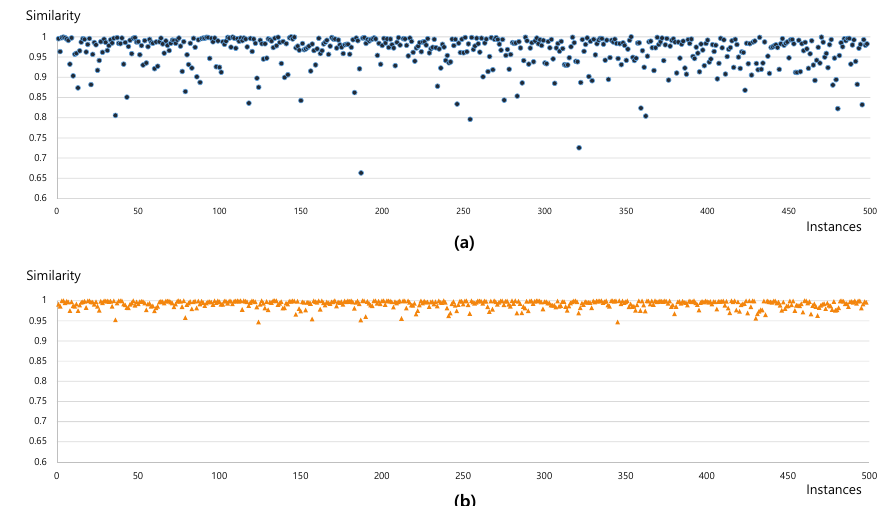
Figure 8. Comparing the performance of similarity ( a ) using a Euclidean distance metric, and ( b ) using a cosine similarity